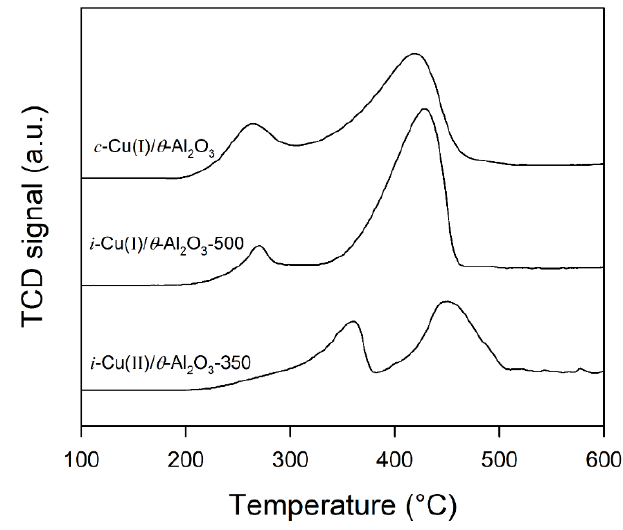
Figure 6. H 2 temperature-programmed reduction (H 2 -TPR) profiles of c-Cu(I)/θ-Al 2 O 3 , i-Cu(II)/θ- Al 2 O 3 -350 and i-Cu(I)/θ-Al 2 O 3 -500, respectively . 3.5. Adsorption of CO on Impregnated CuCl over θ-Al 2 O 3 Adsorbents Adsorption isotherms of the c -Cu(I)/ θ -Al 2 O 3 and i -Cu(I)/ θ -Al 2 O 3 -500 adsorbents are